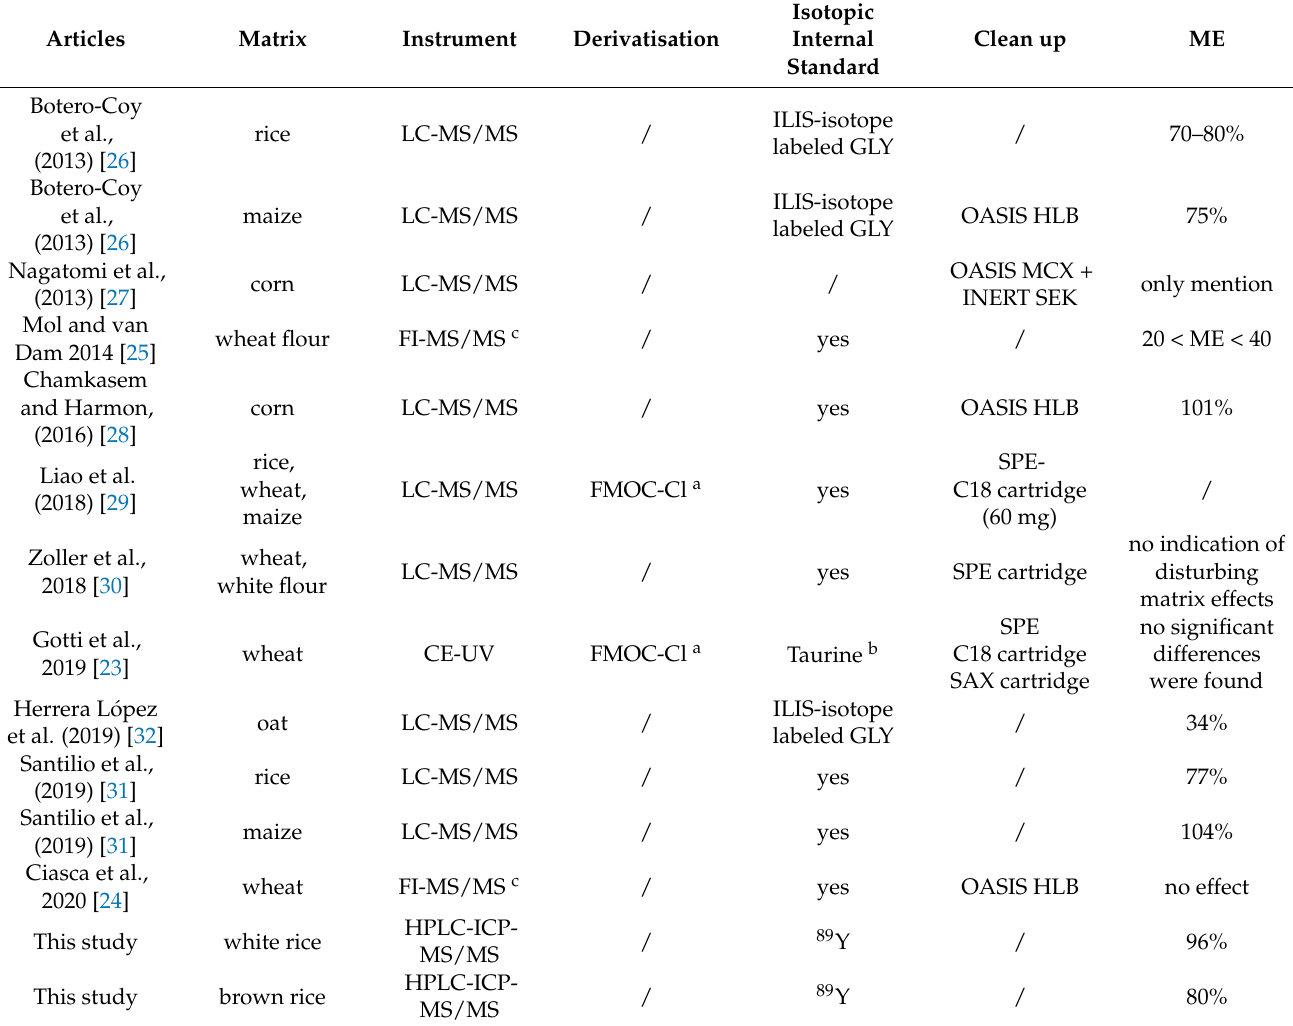
Table 2. Literature on the glyphosate determination in cereals, with details of the matrix